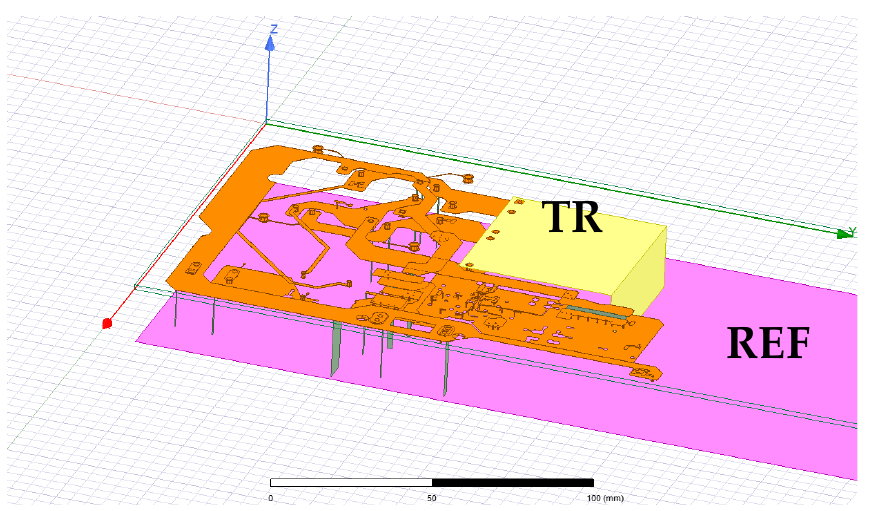
Figure 15. Overview of the 3D model used in HFSS.